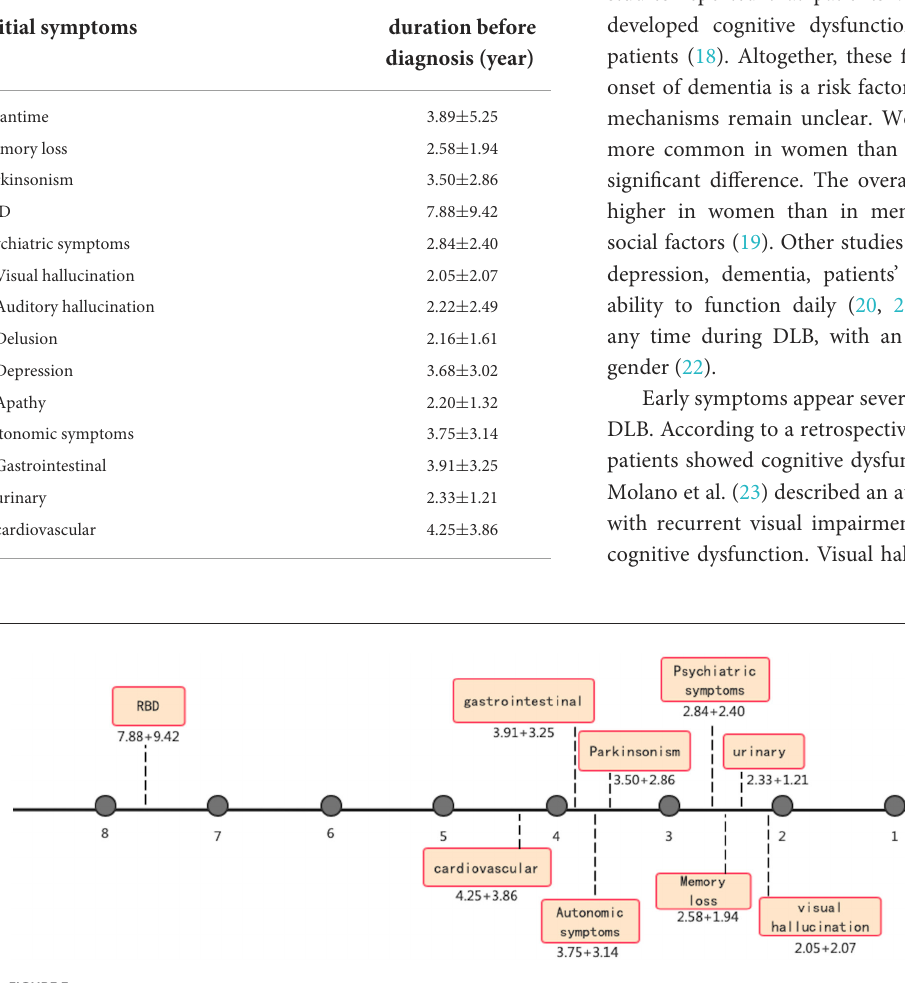
FIGURE3 The duration of initial symptoms before